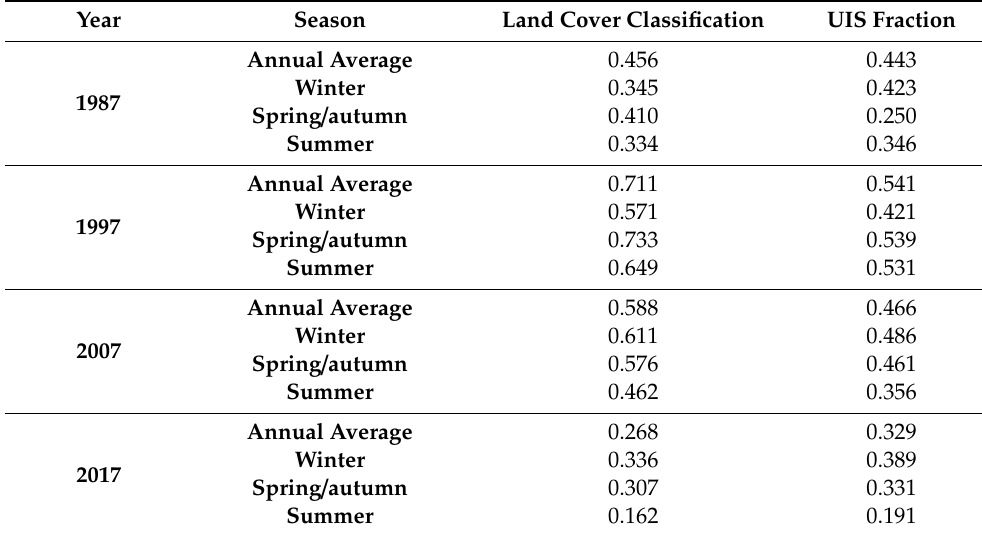
Table 4. Pearson’s correlation coe ffi cient for LSTn to land cover classification and urban impervious surfaces fraction (UIS)